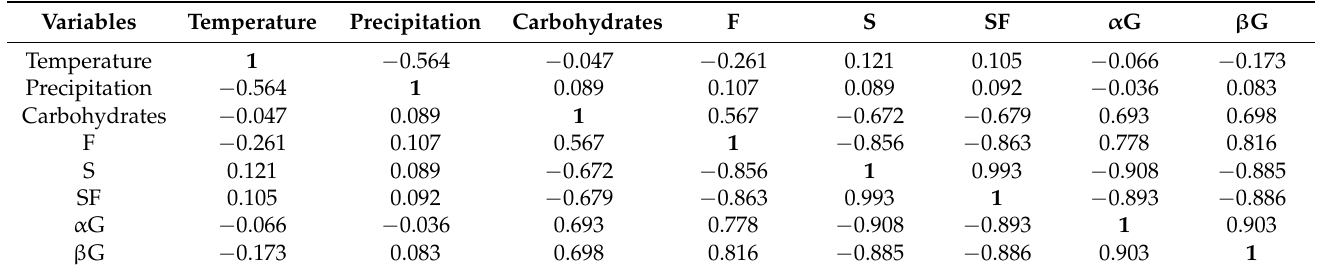
Table 2. Pearson correlation coefficients between precipitation, temperature and